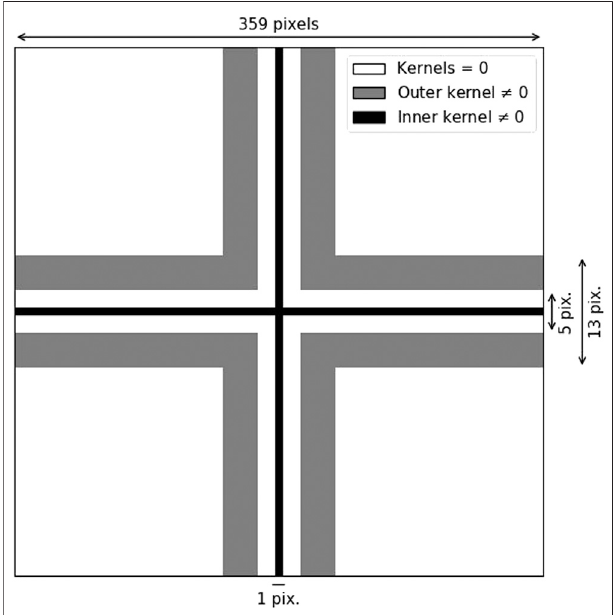
FIGURE 3 | “ Inner ” and “ Outer ” kernels used for the reseau marker detection. Kernel values different from 0 are set such as the sum of all pixels is 1